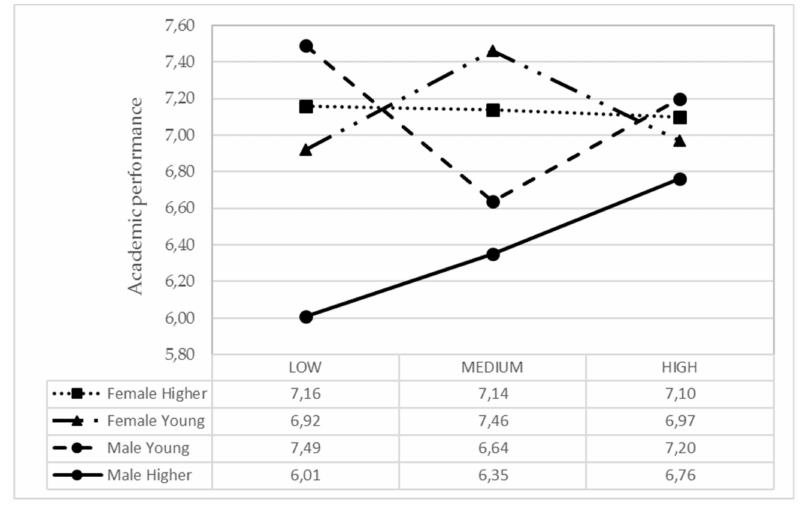
Figure 7. Means of the IPAF4 parental style based on the adolescent gender and age for academic